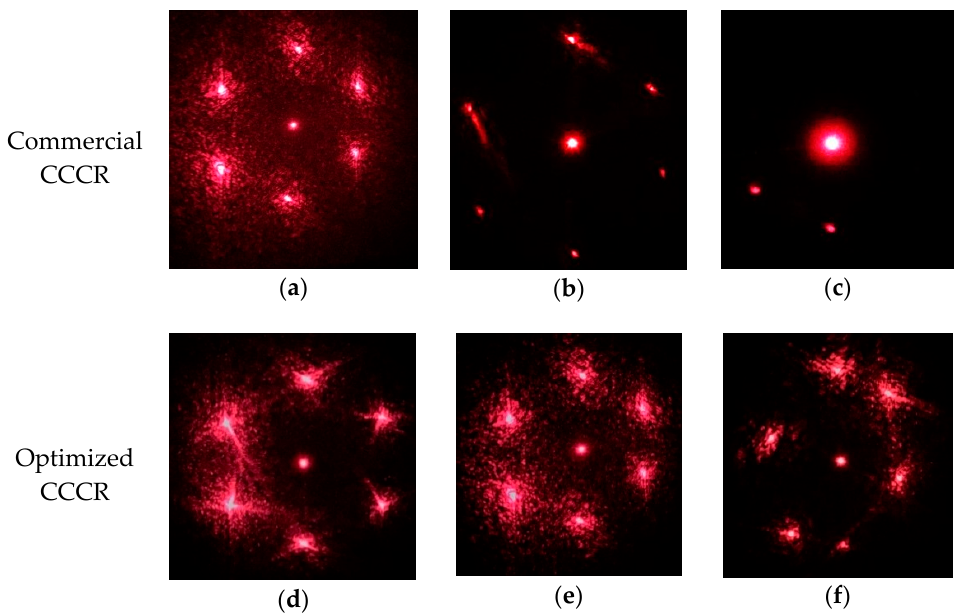
Figure 26. Reflected light distribution for 0 ° incident light beam on anterior, central, and posterior regions of ( a–c ) the commercial CCCR and ( d–f ) the optimized CCCR, respectively.